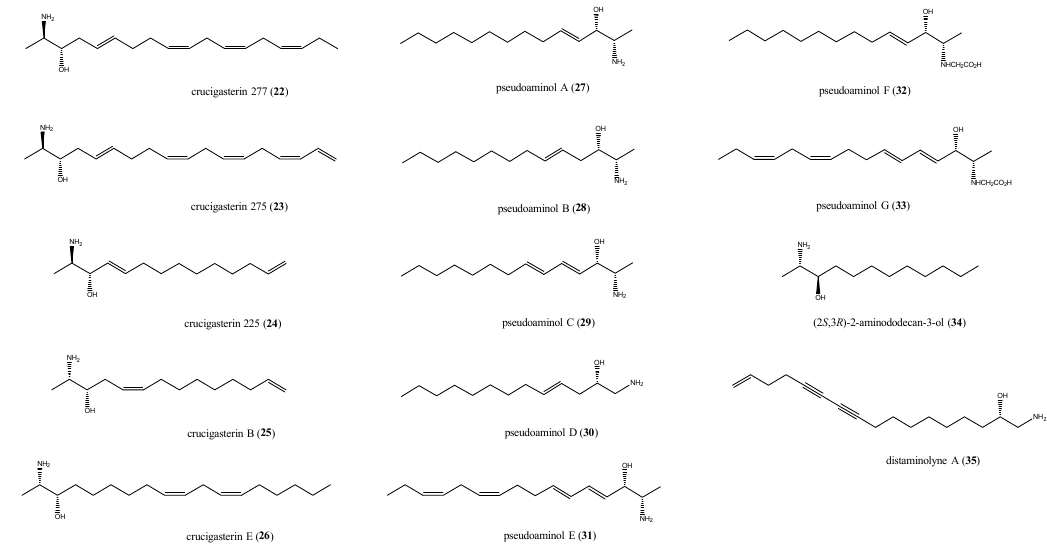
Figure 5. Structures of the amino alcohols crucigasterins ( 22 – 26 ), pseudoaminols ( 27 – 33 ), (2 S , 3 R )-2-aminododecan-3-ol ( 34 ), and distaminolyne A ( 35 ).